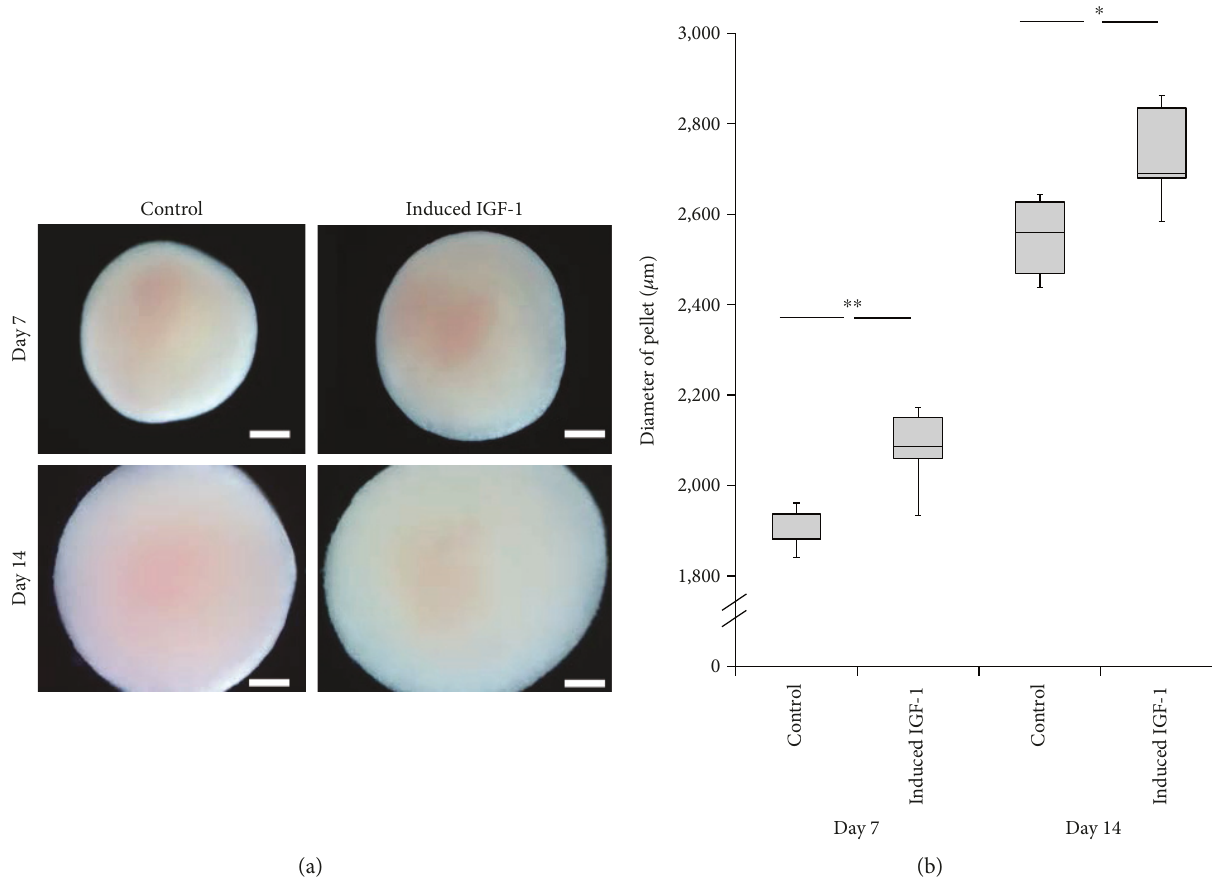
Figure 1: Diameters of the pellet cultures after 7 and 14 days of chondrogenic di ff erentiation. (a) Microscopic fi ndings: control (left) versus IGF-1 gene transferred cell-derived pellets (right). Showing results after 7 days (upper) and 14 days (lower). Scale bars=500 μ m. (b) Graph showing the diameter of the pellet cultures after 7 and 14 days. Vertical axis: diameters ( μ m); horizontal axis: the control (left) versus induced IGF-1 (right). Statistical analysis using independent samples t -test, ∗∗ p < 0 01 , ∗ p < 0